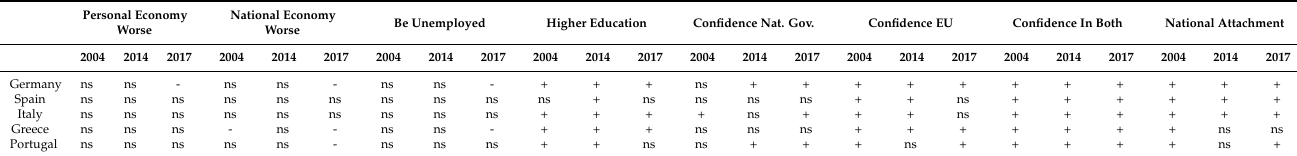
Figure 6. AMEs of the attachment to the nation in the probability of attachment to Europe by year, with 95% CIs. Source: Own elaboration from Eurobarometer. Table 1. Summary of results for attachment to